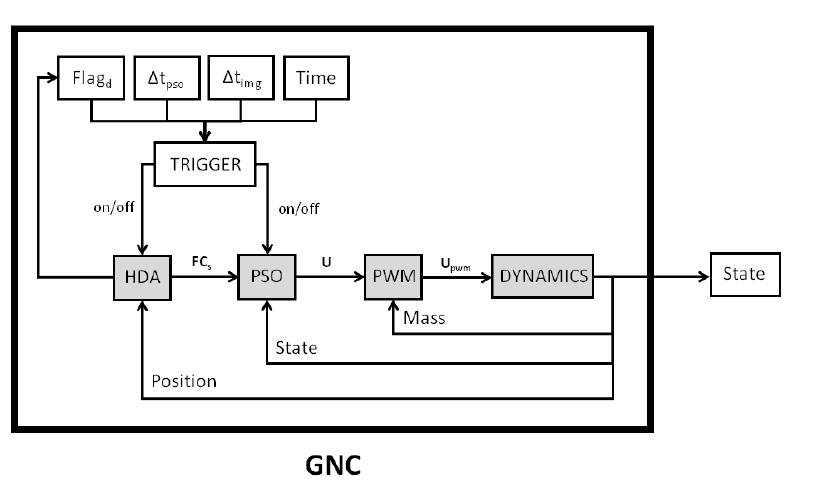
Figure 20. Low level blocks of the GNC